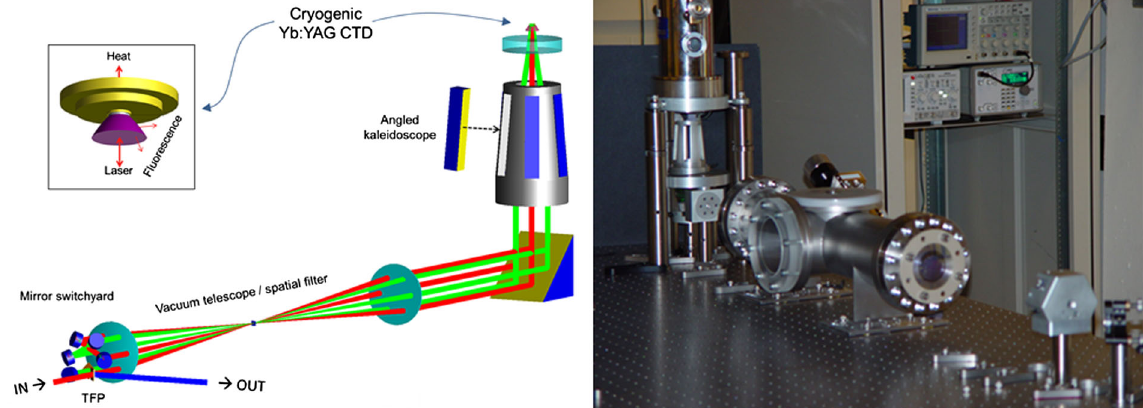
FIG. 15. The key components in our high average-power high pulse-energy chirped pulse amplifier design are a shaped composite- thin-disk gain element (inset in the left panel) that is cryogenically cooled and a passively switched strictly image relayed multipass architecture utilizing a beam-smoothing telescope. A photograph of the hardware is on the right.